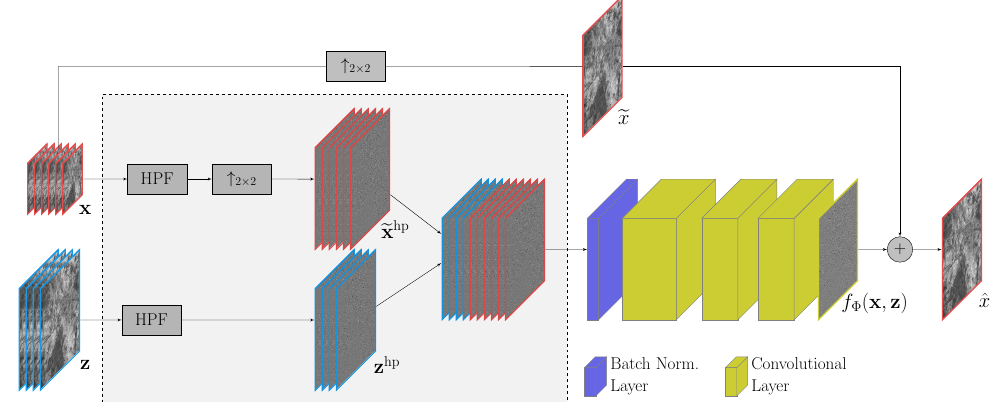
Figure 3. Top-level workflow for the super-resolution of any 20 m band of Sentinel-2. The dashed box gathers the shared processin,g which is the same for all predictors.